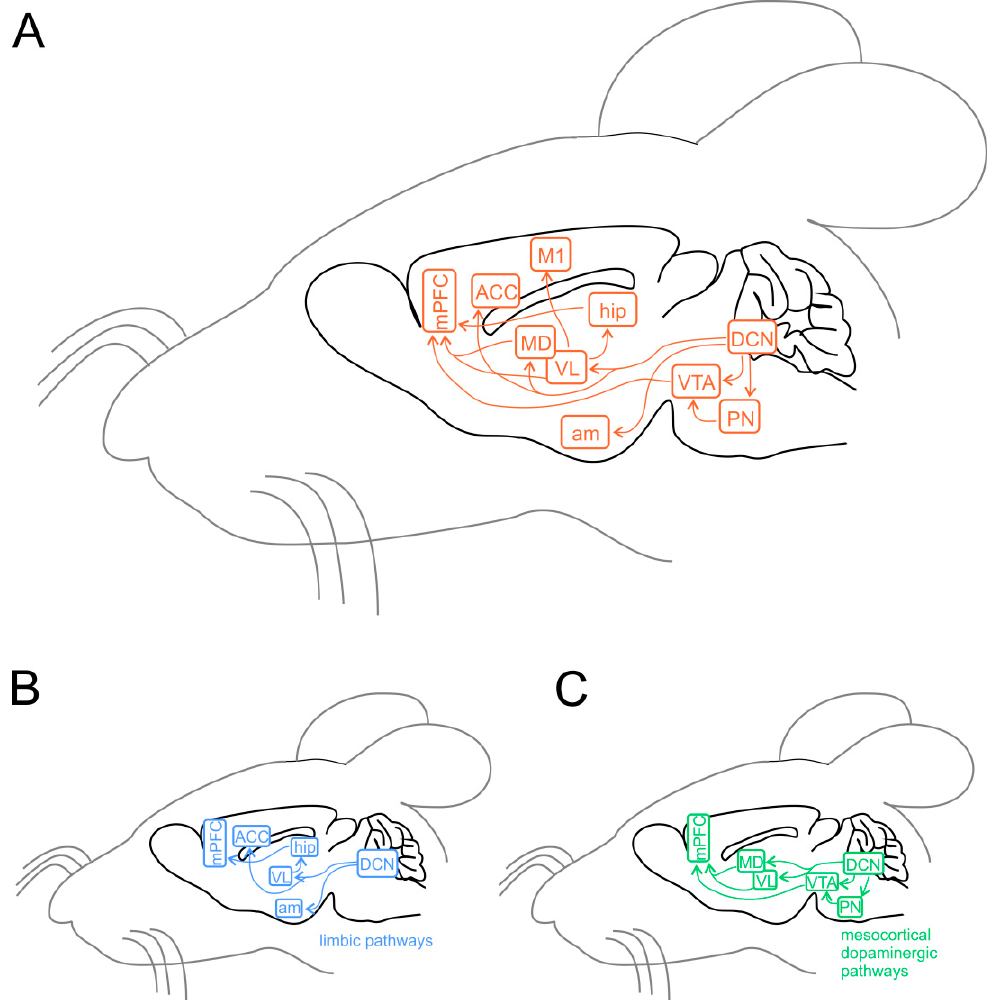
Figure 3. Cerebellar connectivity to other brain areas. The cerebellum is one of the most intercon- nected structures in the brain. ( A ) Schematic representation of the mouse brain and the main cerebellar connections thought to be relevant for its role in ASD. DCN, deep cerebellar nuclei; PN, pontine nuclei (including reticulo-tegmental nuclei and pedunculopontine nuclei); VTA, ventral tegmental area; am, amygdala; hip, hippocampus; VL, ventrolateral thalamic nucleus; MD, mediodorsal thalamic nucleus; M1, primary motor cortex; ACC, anterior cingulate cortex; mPFC, medial prefrontal cortex. ( B ) Same representation as in ( A ), showing the pathways involving the limbic system. ( C ) Same representation as in ( A ), showing the connections involved in the mesocortical dopaminergic pathways, regulating mPFC activity